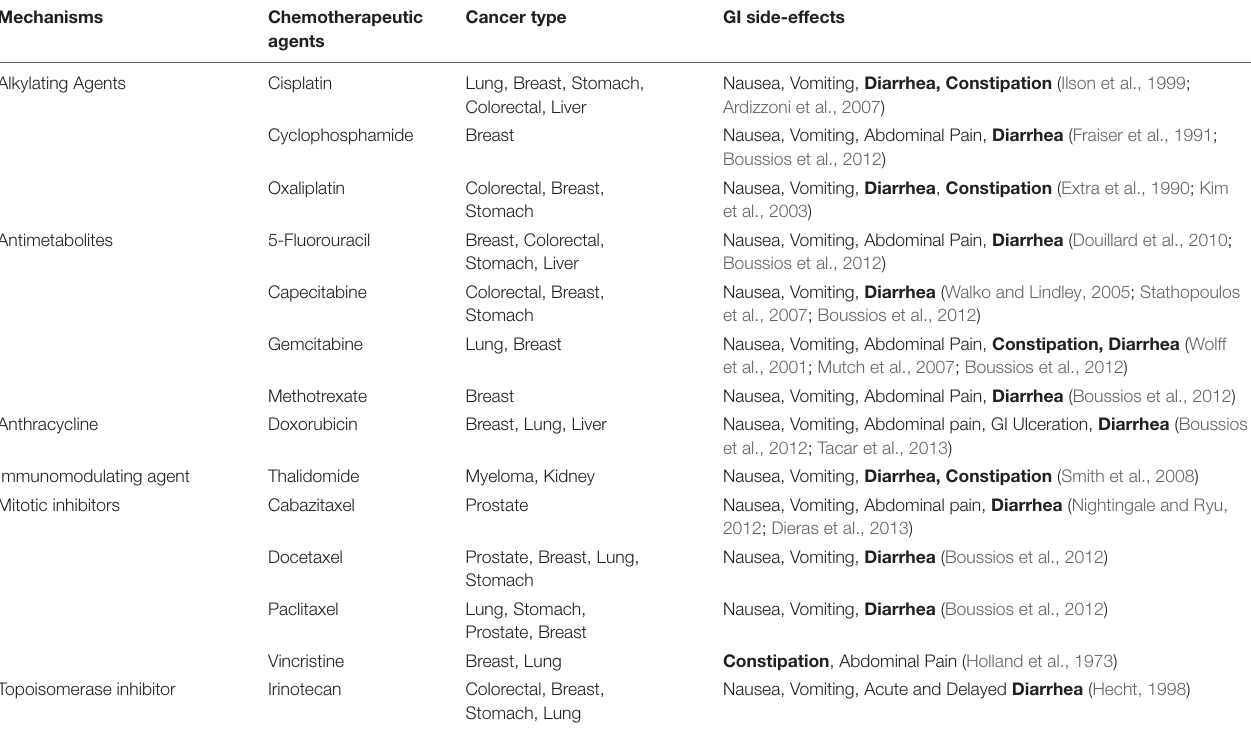
TABLE 1 | Gastrointestinal side-effects of chemotherapy.